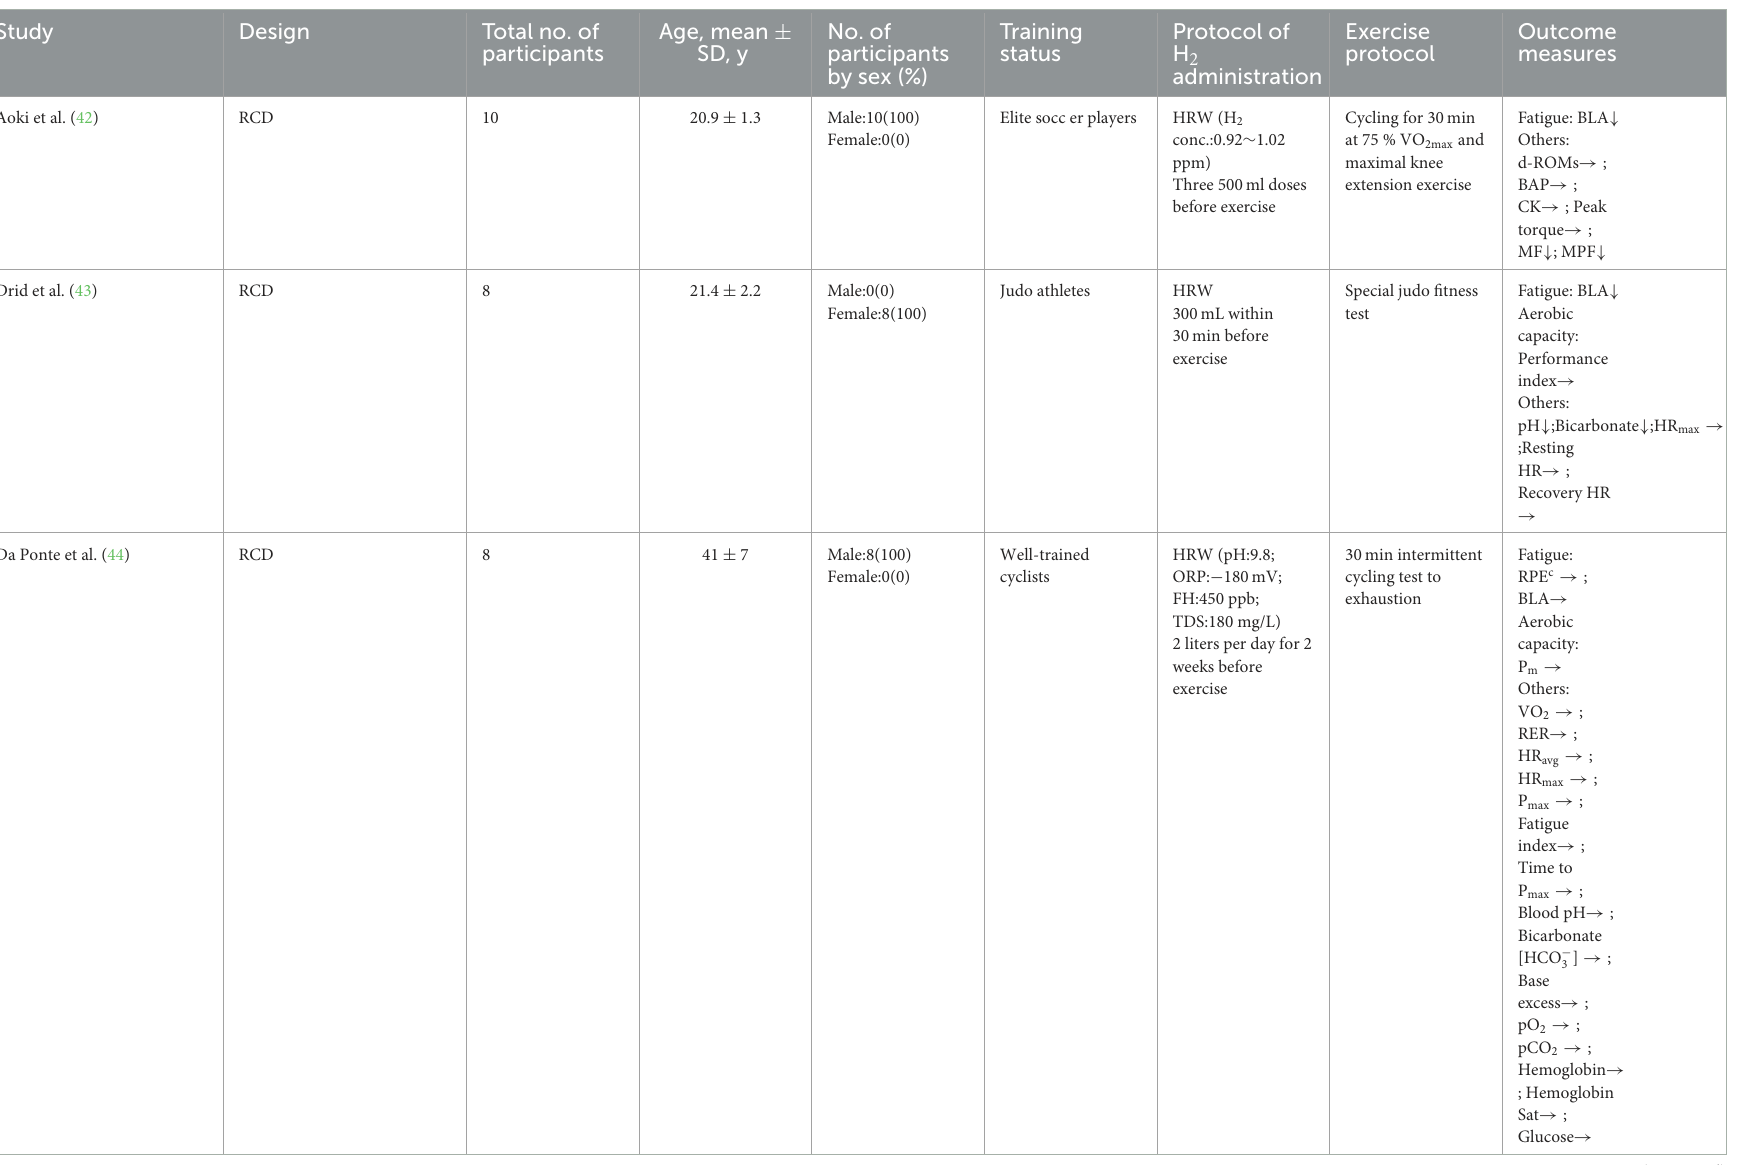
TABLE 1 Characteristics of the included studies ( n =